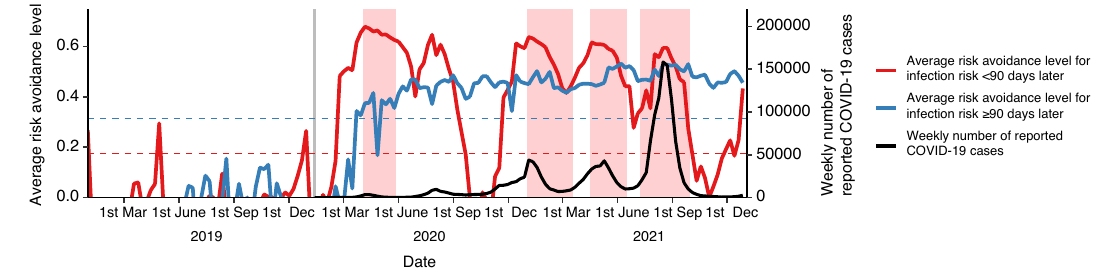
Figure 2. Comparison of travel avoidance levels by short-term and long-term prediction. True lines show the average travel avoidance level for the travel < 90 days later (red) and that for the travel ≥ 90 days later (blue), respectively. Black true line shows weekly number of reported COVID-19 cases in all of Japan. Dashed lines show 95 percentiles of the average travel avoidance level for the travel < 90 days later (red) and ≥ 90 days later (blue). Grey vertical line shows the timing of first the COVID-19 case in